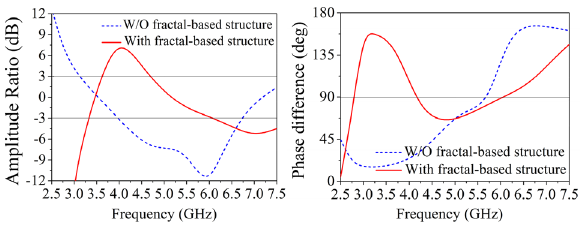
Figure 4. Amplitude ratio and phase difference of two orthogonal modes in reference antenna II.